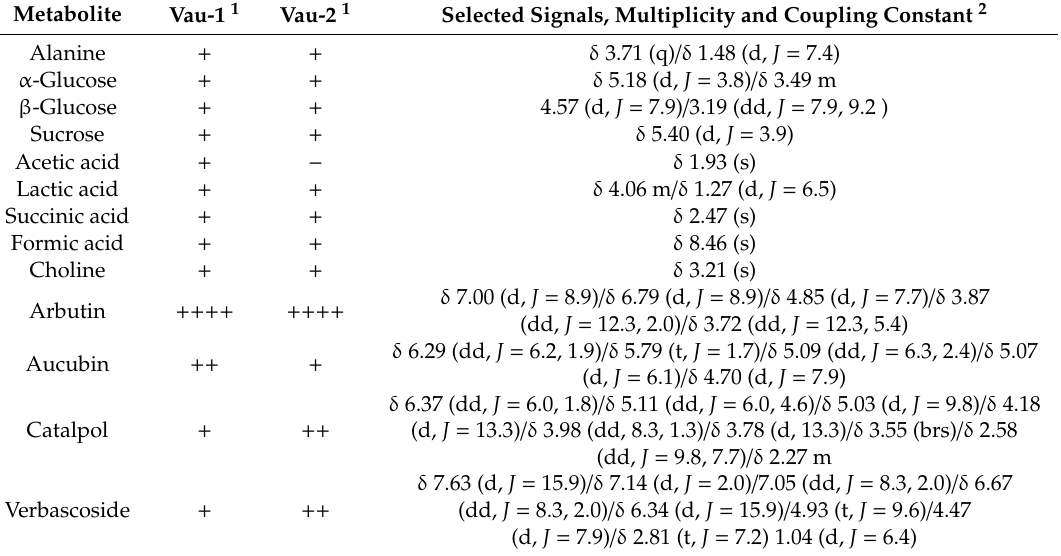
Table 1. V. austriaca L. metabolites, identified by relevant 1D and 2D NMR spectra.